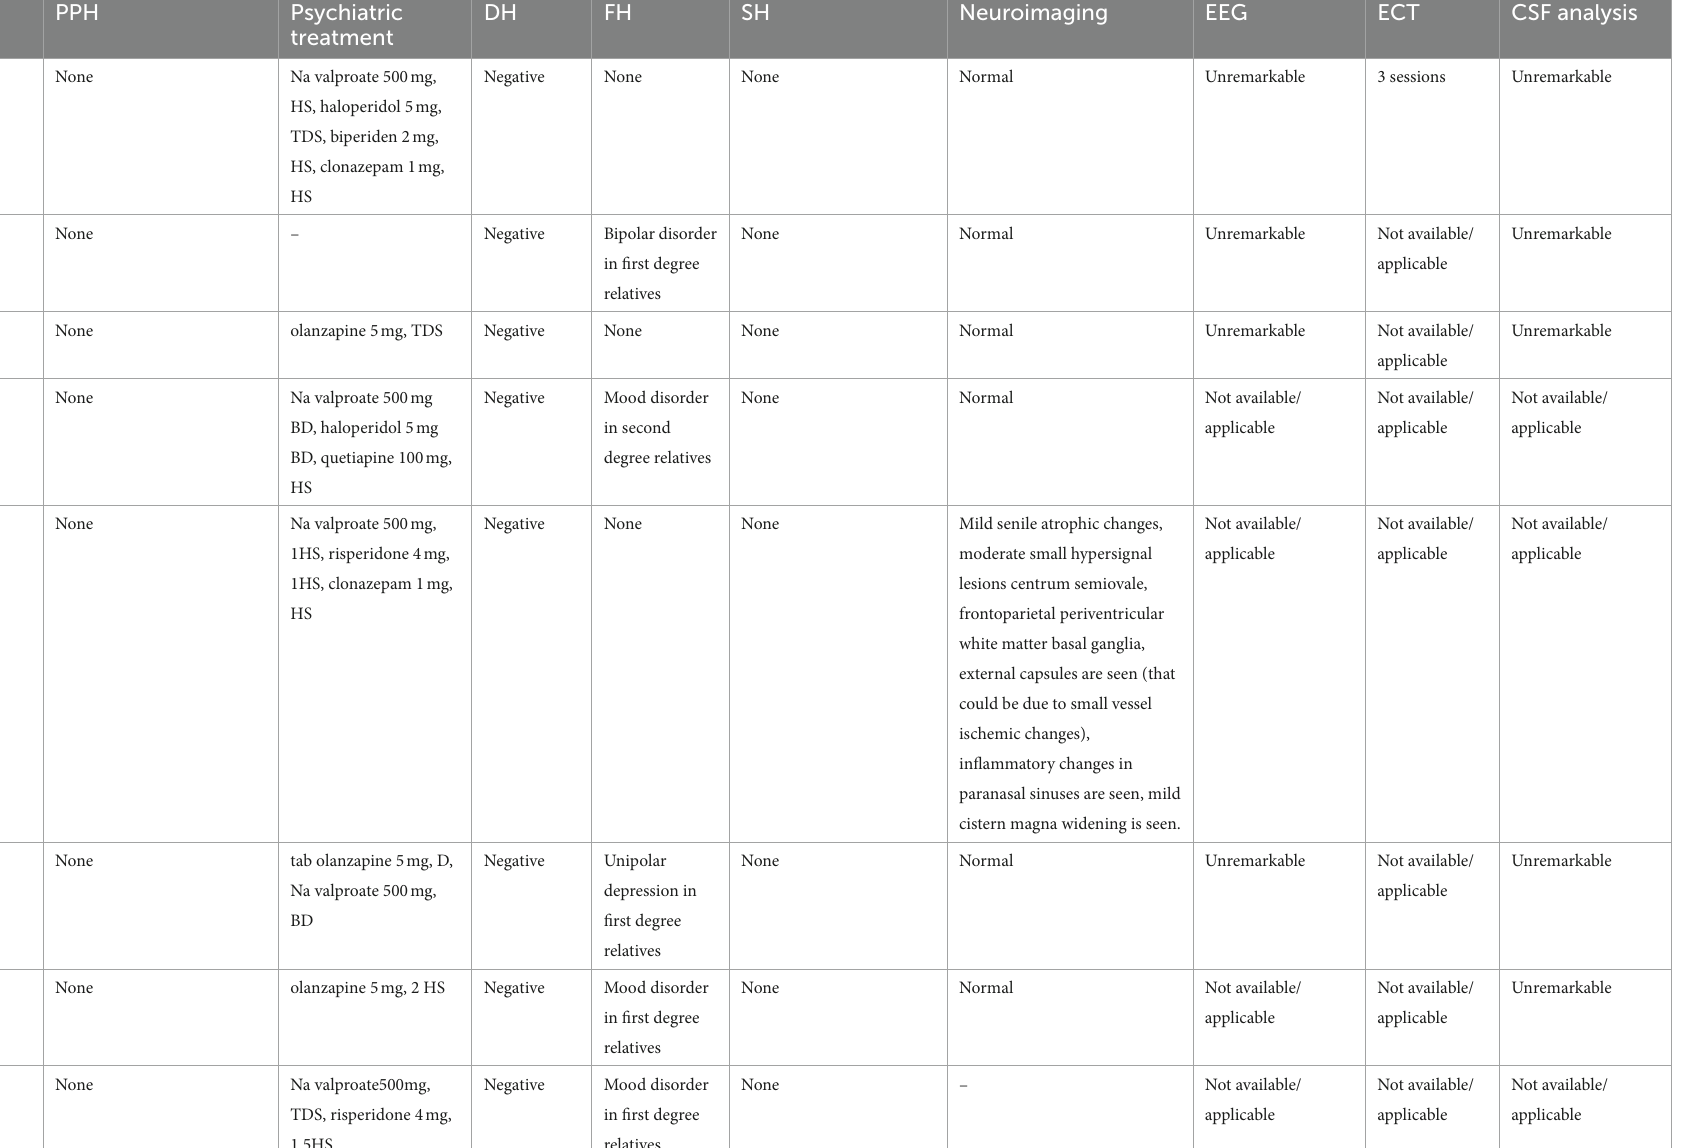
TABLE 1-2 Characteristics and imaging of patients with post-COVID mania in the current study.